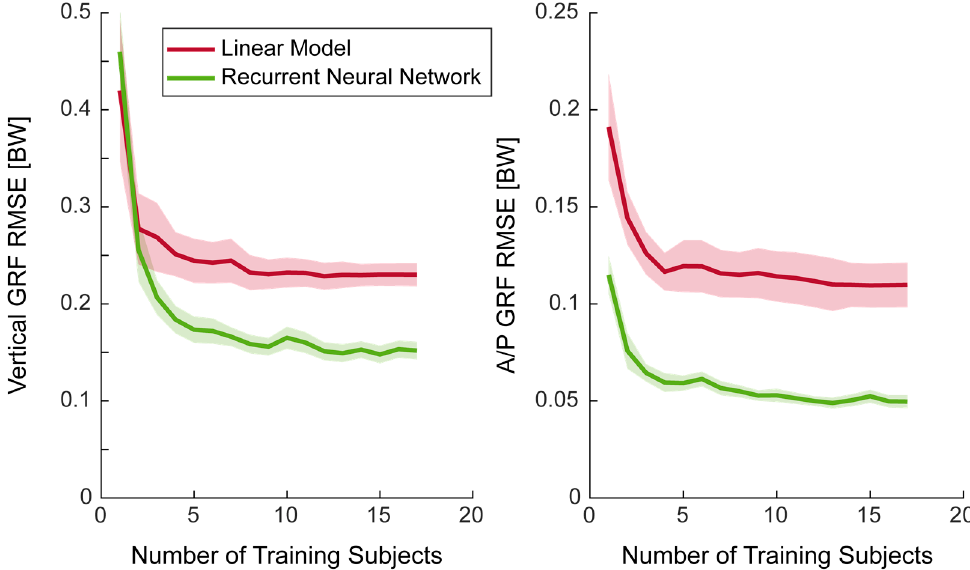
Figure A1. Root mean squared errors (RMSE) of ground reaction force (GRF) prediction with increasing number of subjects included in training the models. Present data are means (solid line) of all subjects and conditions evaluated and standard deviations (clouds). The model errors for each subject were evaluated such that the values of 17 training subjects (the right − hand side of each plot) corresponds to the average leave − one − subject − out error across all conditions.